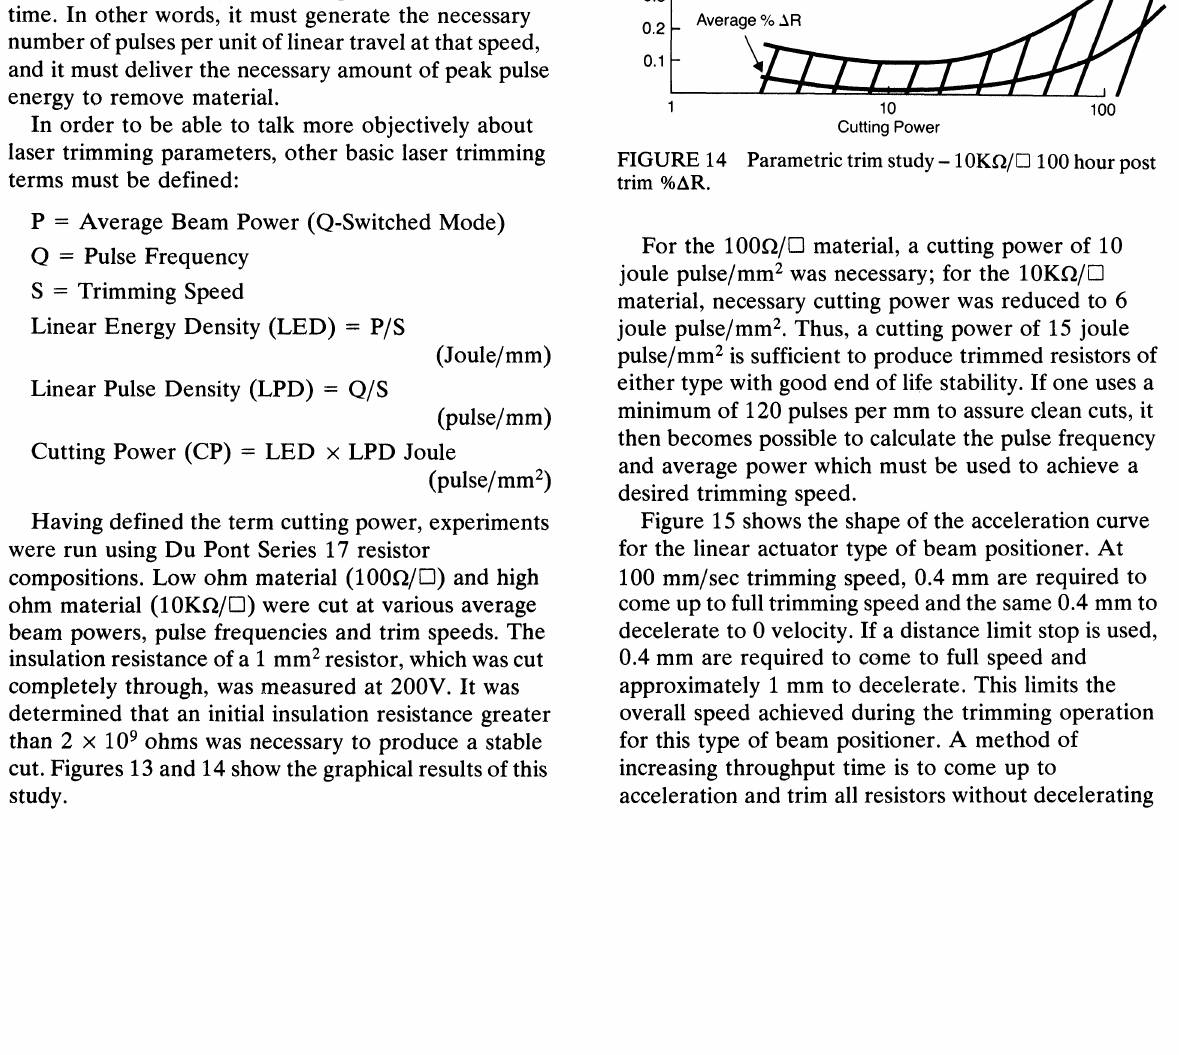
FIGURE 13 Parametric trim study 1000f/Z] 100 hour post trim %AR.